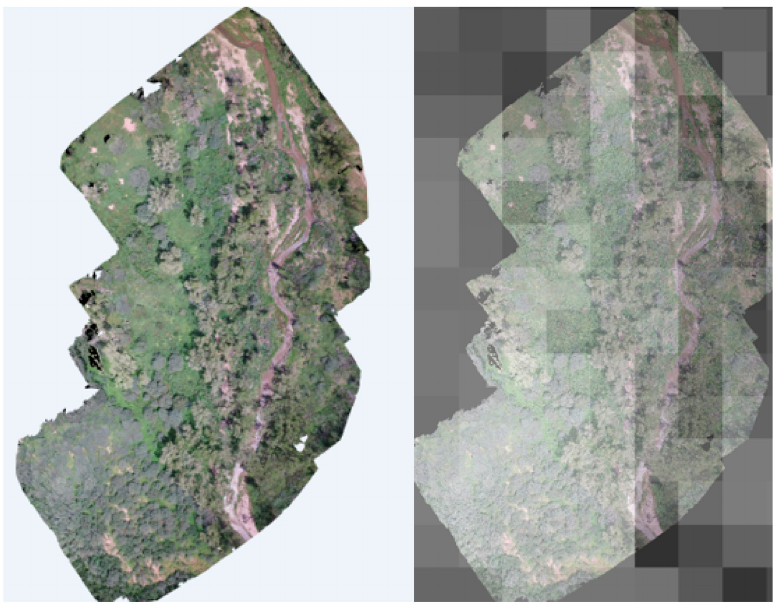
Figure 2. Left : Orthomosaic showing the river section in Galera site. Right : Image showing the over-positioning of orthomosaic on Landsat scene, each square represents a Landsat pixel.